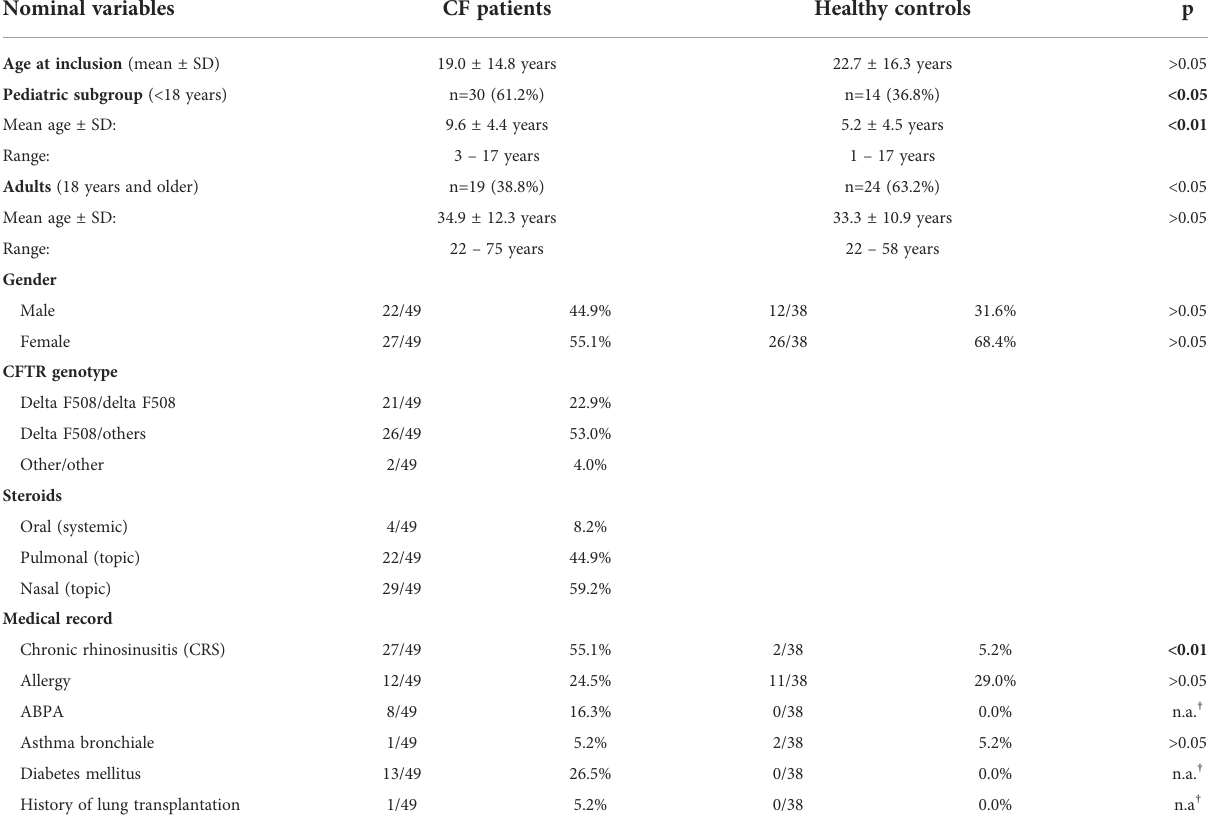
TABLE 1 Demographic data of included CF patients and healthy